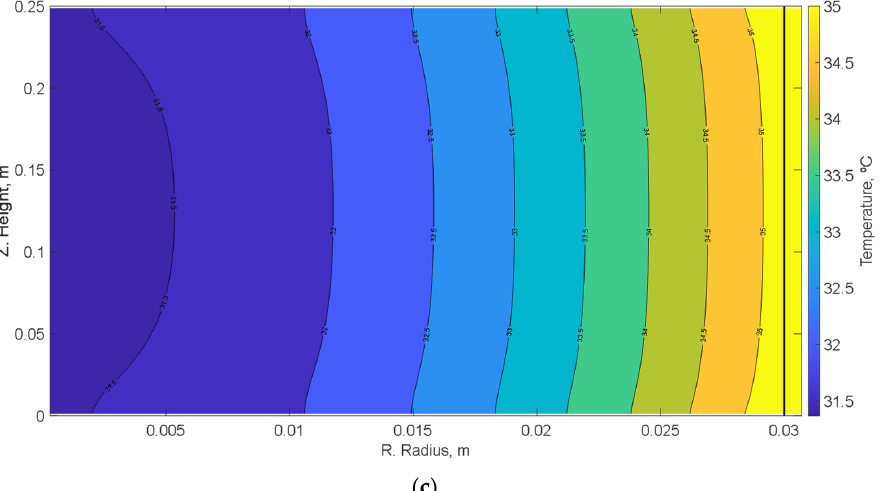
Figure 12. Distribution of temperatures for each of the materials at one hour and an ambient temperature of 40 °C. ( a ) Al319, ( b ) PET, and ( c ) PP.